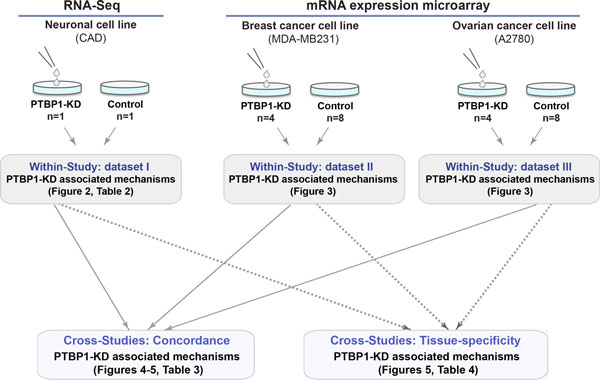
Experimental design.